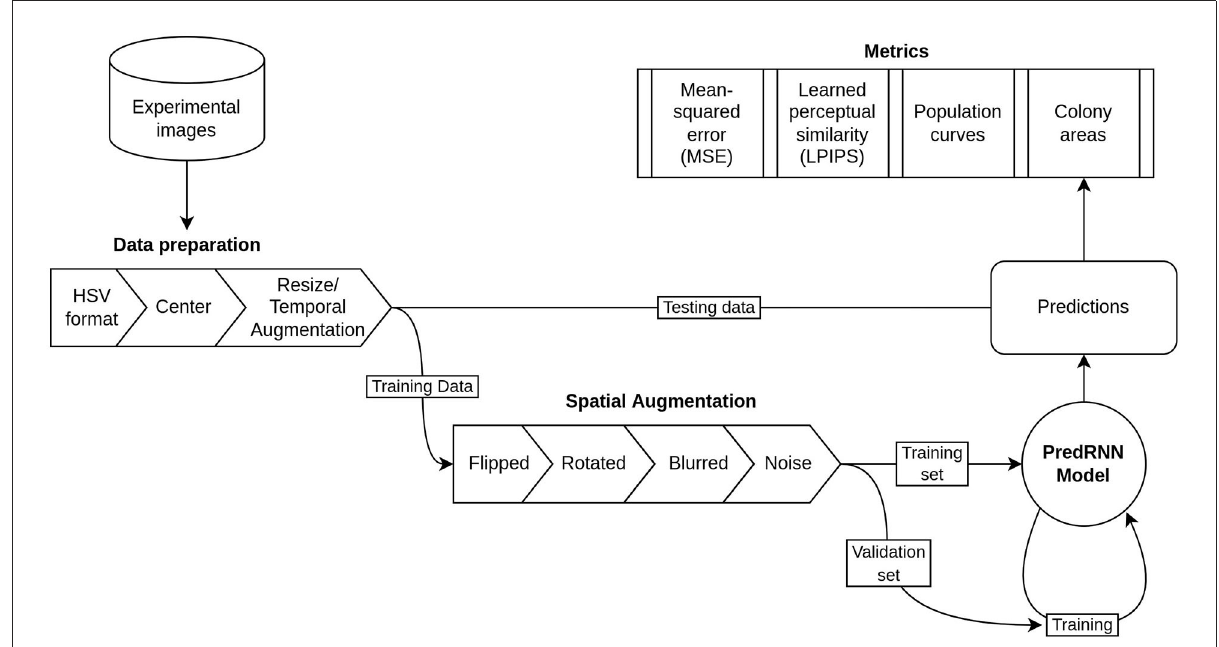
FIGURE2 Flow chart of the data and model pipeline including preprocessing steps, dataset separation, and validation